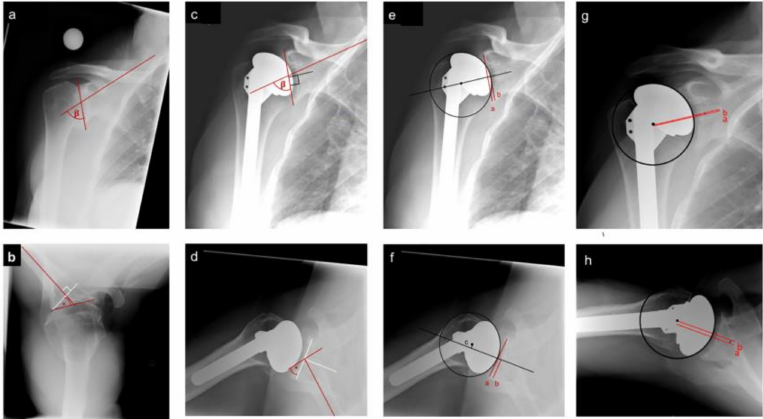
Figure 2. Radiographic measurements: ( a ) Pre-operative inclination = 90 − β , where β is the